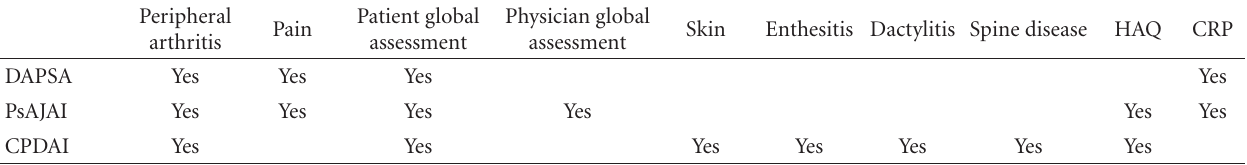
Table 2: Clinical domains included in composite measures in PsA.